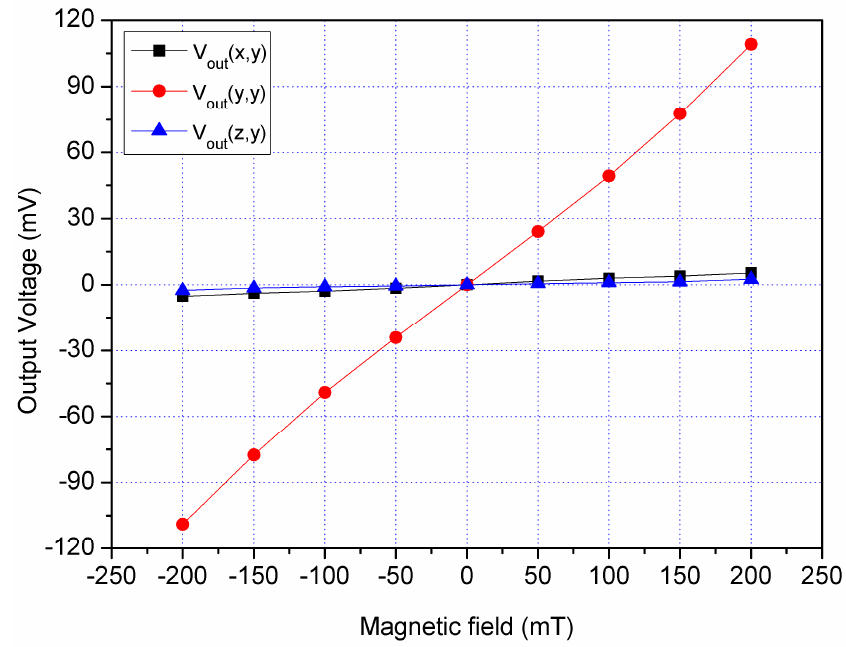
Figure 19. Measured Vo for the MS in the y-direction MF.